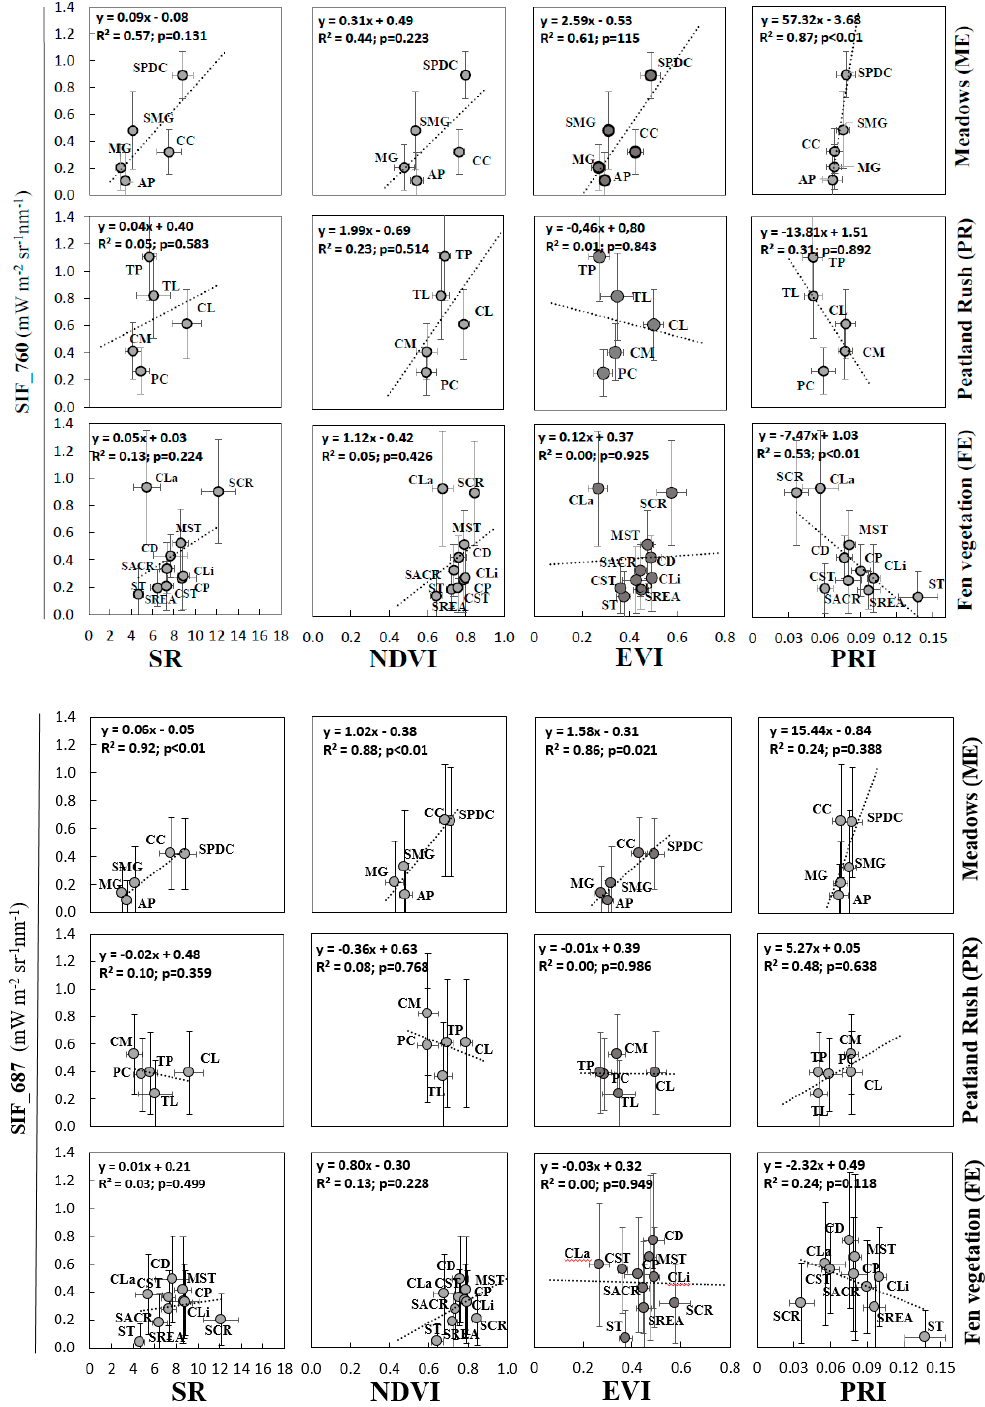
Figure 10. Correlation analysis of SIF at 760 nm and at 687 nm with selected remotely-sensed vegetation indices (SR, NDVI, EVI, and PRI) at vegetation community level restricted to peatland area. Plant communities were grouped in three categories comprised of meadows (ME), peatland rush vegetation (PR), and fen vegetation (FE), and were presented separately for each group. Codes names correspond to those provided with Figure 3. Error bars represent standard